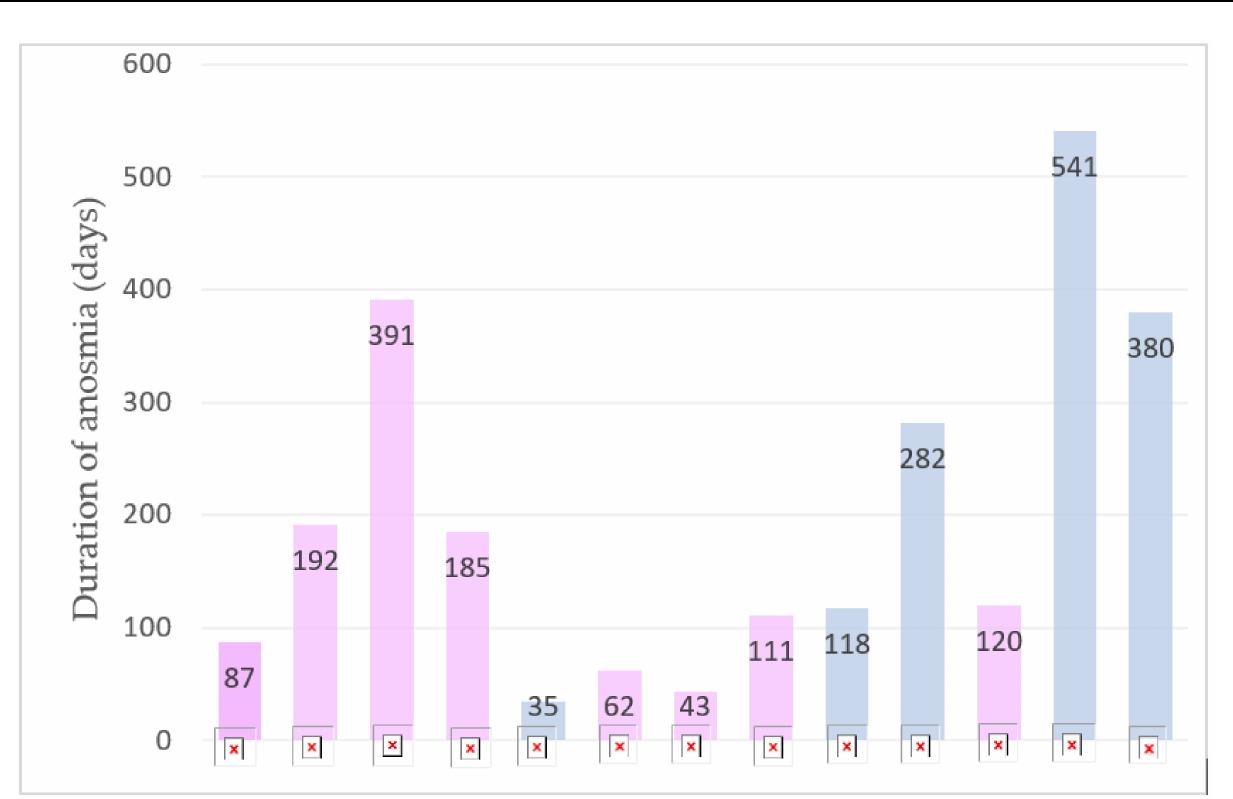
Figure 1. Duration of anosmia (days) in the 13 children.